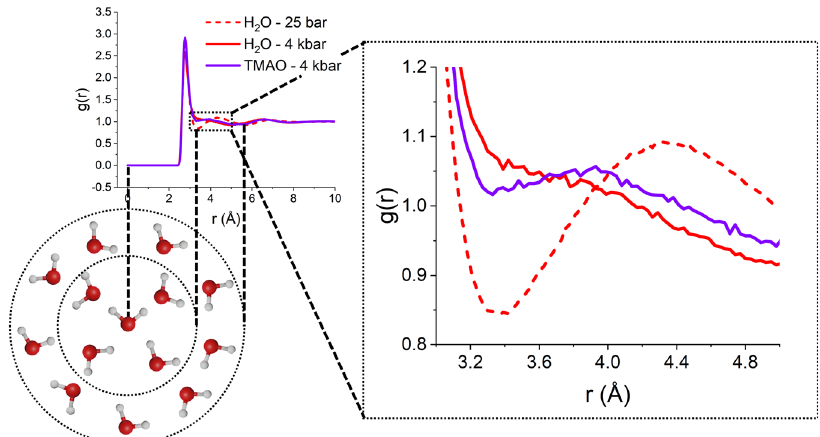
Fig. 2 Water – water g(r)s . O w O w g ( r ) s for pure water (red) and aqueous TMAO (purple) at 25 bar (dashed) and 4 kbar (solid) (Aqueous TMAO at 25 bar not displayed for clarity and can be found in the SI, Fig. S1). Schematic illustration below g ( r ) demonstrates how the peaks in the g ( r ) correspond to